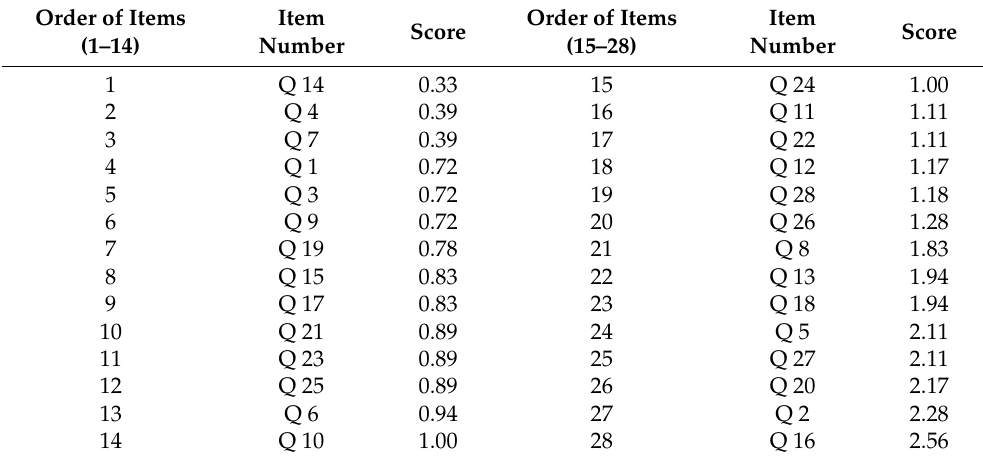
Table 4. Ranking of 28 items—SQS.